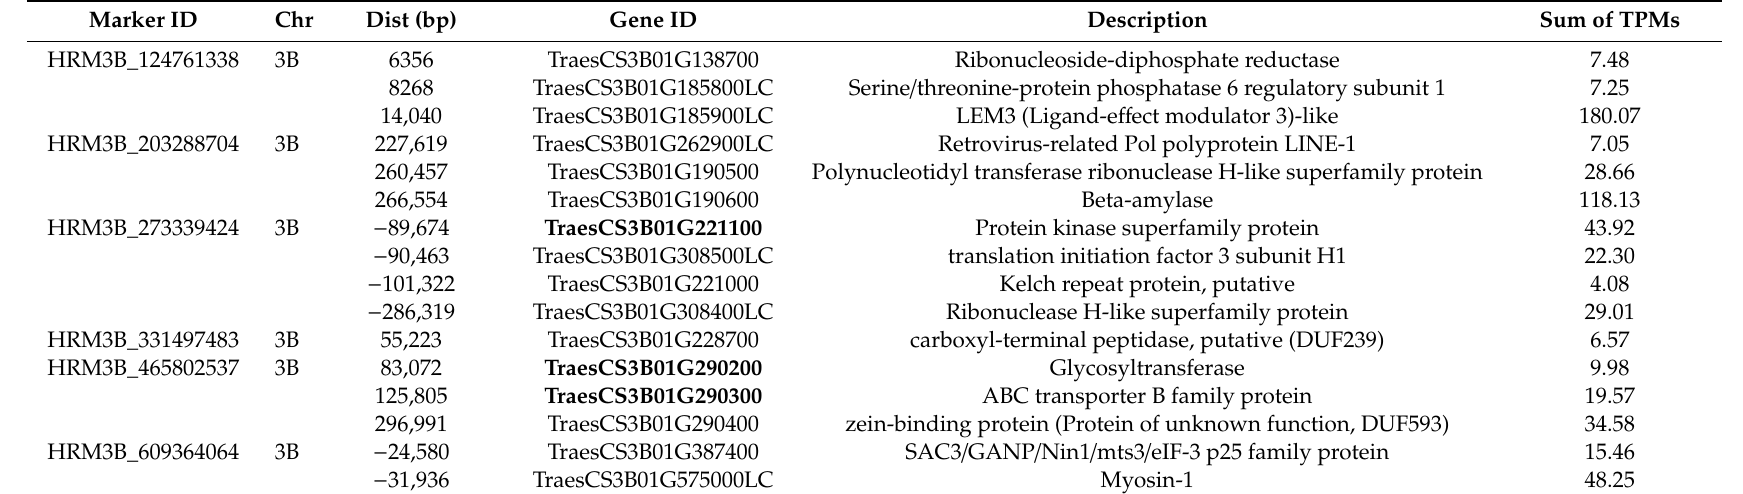
Table 3. Wheat chromosome 3B ISBP markers linked to genes which alter their expression in response to water stress treatments. DE genes are shown in bold. The positive and negative values in “ Dist ” column indicate if the corresponding gene is downstream or upstream of the corresponding marker.